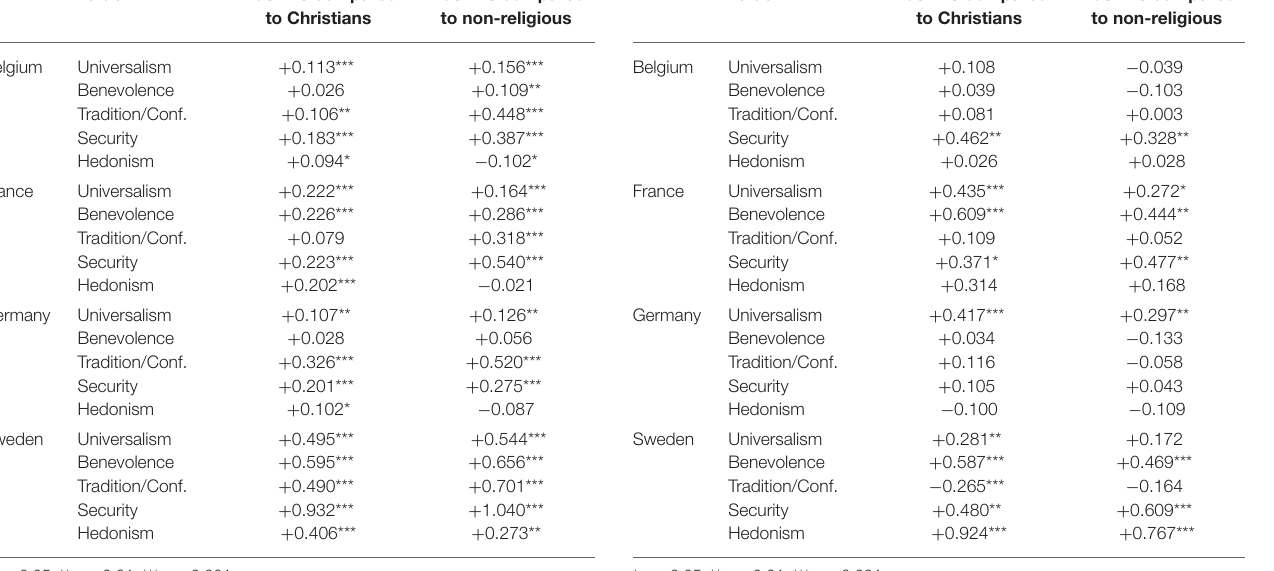
TABLE 4 | Comparison of latent means of values. TABLE 5 | Comparisons of latent means of values when controlling for religiosity. Value Muslims compared Muslims compared to Christians to non-religious